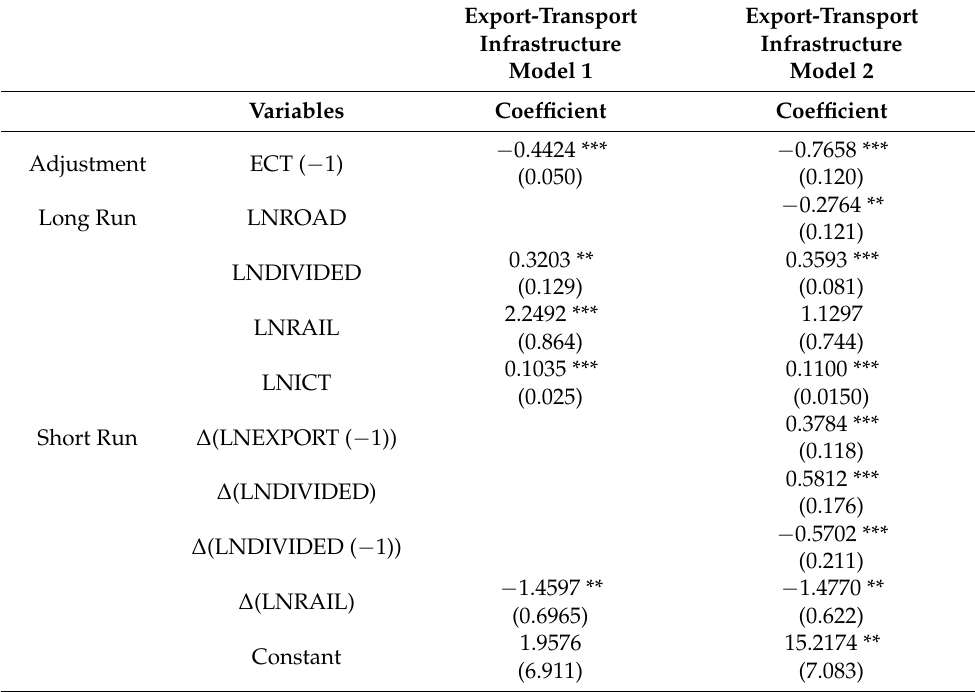
Table 5. ARDL models for exports.